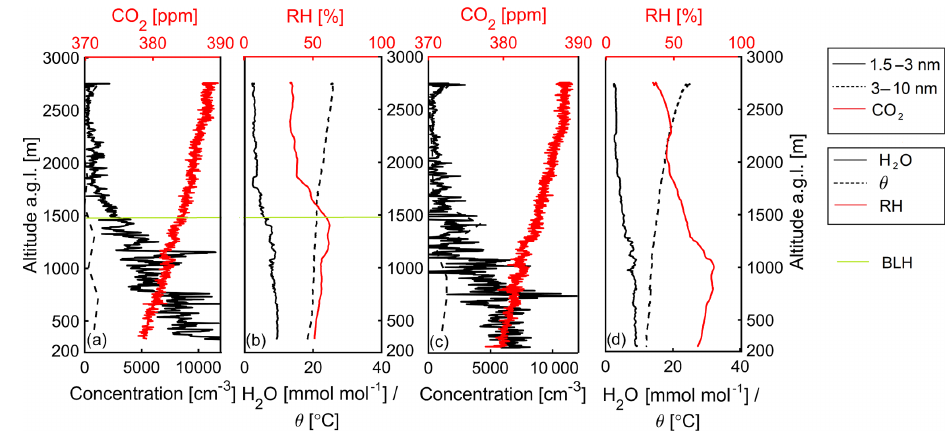
Figure 7. Measurement profiles like in the previous figure, but during the second measurement flight on 13 August 2015 at